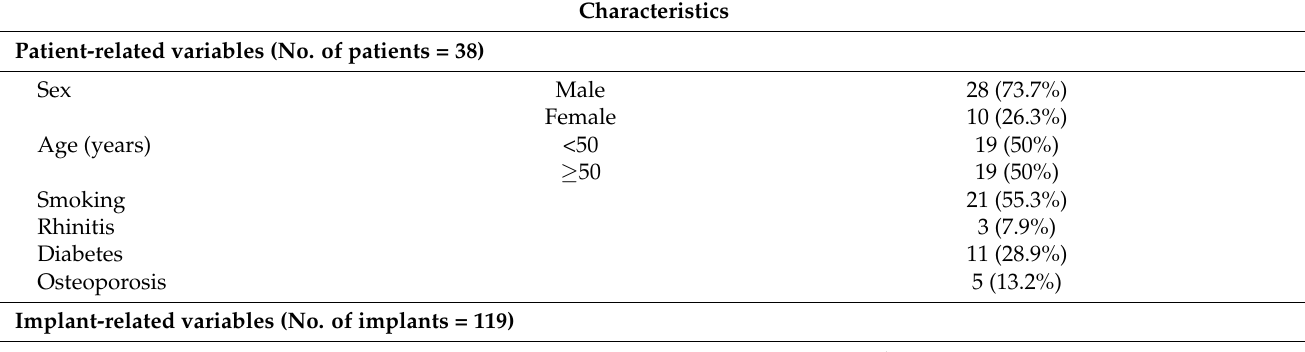
Table 1. Characteristics of patients and implants placed in maxillary molars with and without maxillary sinus floor augmentation